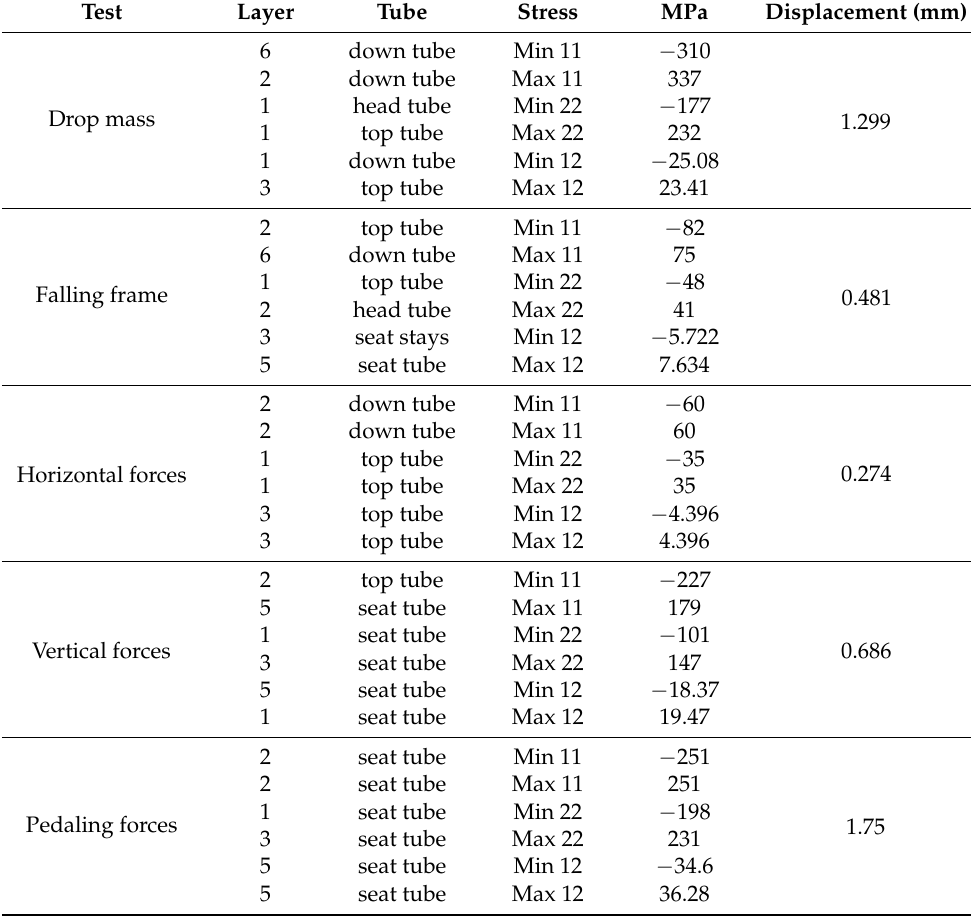
Table 22. Stress and displacement results of stacking scenario 4.